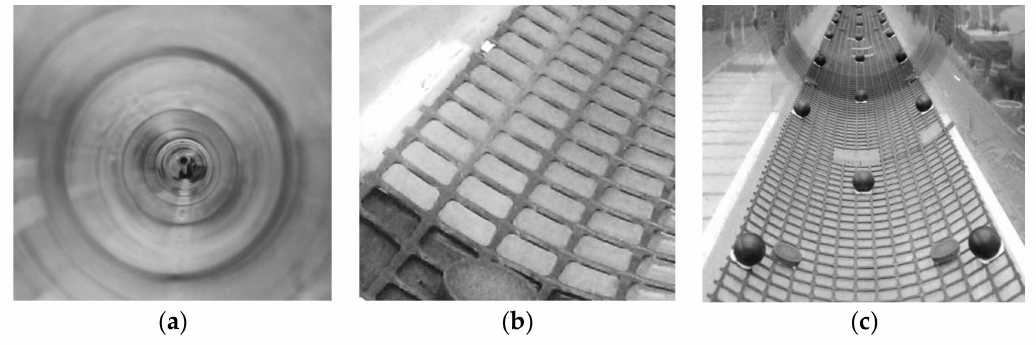
Figure 2. Three pipe bed conditions: clean/empty pipe ( a ); pipe with mesh ( b ) and pipe with 8D separated spheres ( c